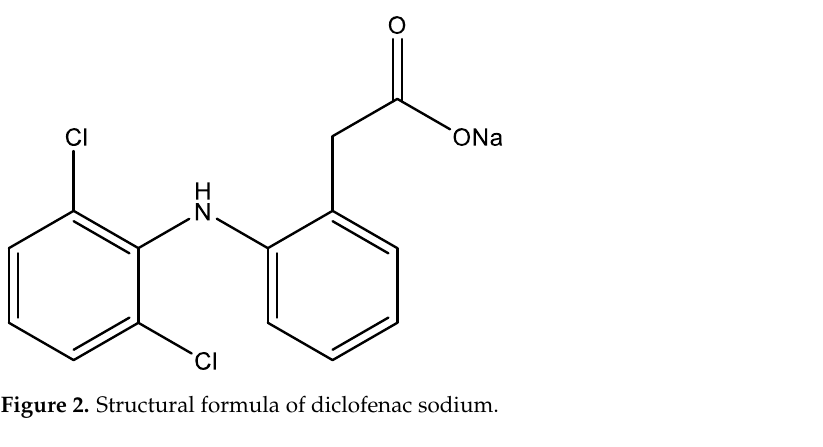
Figure 2. Structural formula of diclofenac sodium.